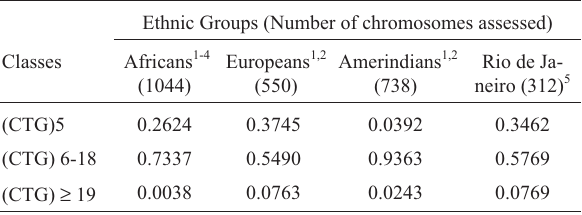
Table 1 - Frequencies of (CTG)n classes in Africans, Europeans, Amerindians and the Brazilians from the present study. Ethnic Groups (Number of chromosomes assessed)